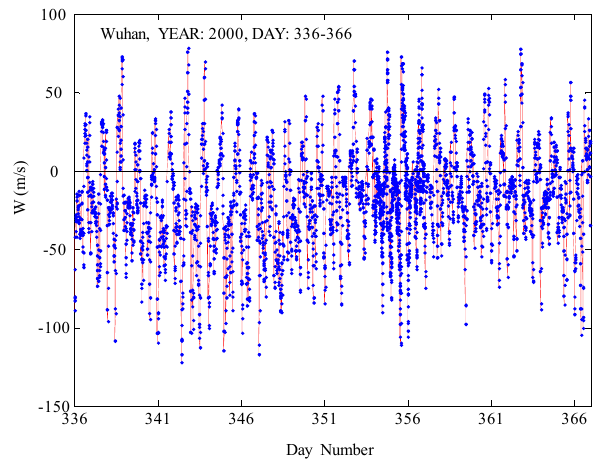
Fig. 7. Same as Fig. 5 but for days 336–366, 2000.